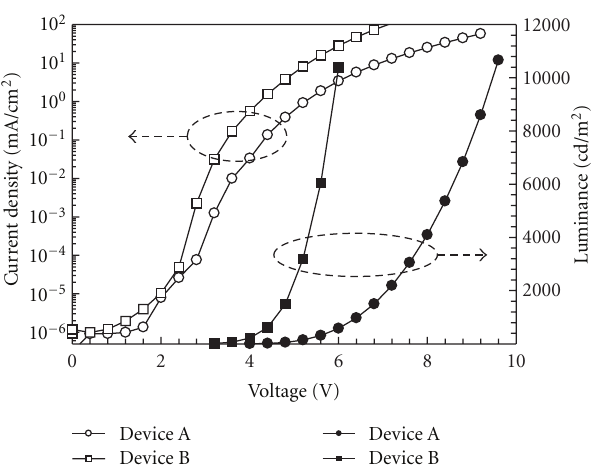
Figure 3: J - V - L and e ffi ciency characteristics of Devices A and B. Figure 4: J - V - L and e ffi ciency characteristics of Devices C, D, and